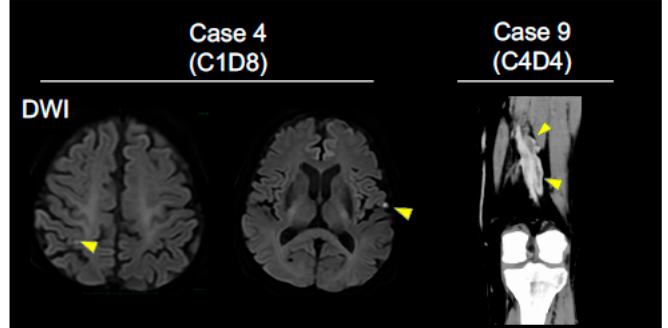
Figure 1. Key imaging in NSCLC patients who developed diseases associated with disorders of the coagulation-fibrinolysis. Brain MRI images (DWI) show multiple cerebral infarctions (arrowheads) (Case 4; cycle 1 day 8, C1D8, left panel). Contrast-enhanced CT image of leg vein shows deep vein thrombosis (arrowheads) (Case 9; C4D4, right panel).